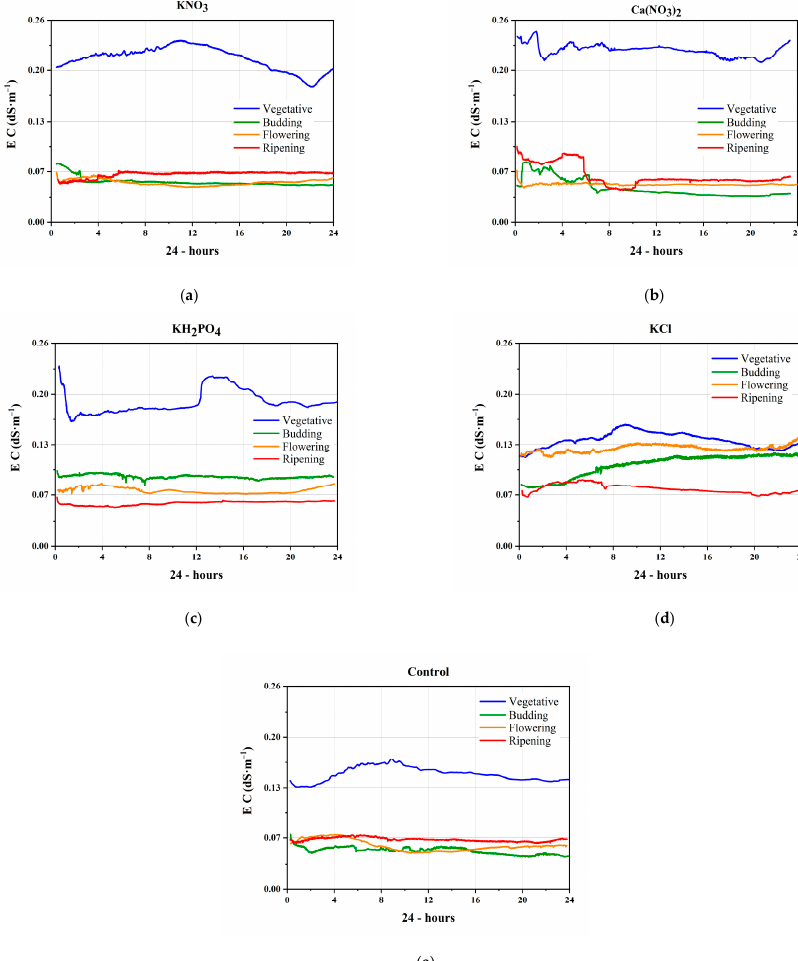
Figure 3. The 24 h electrical conductivities measured in different physiological stages for potassium nitrate ( a ), calcium nitrate ( b ), potassium dihydrogen phosphate ( c ), potassium chloride ( d ) and control ( e ). The 24 h ECs were recorded from the first day, at 9.30 a.m. till the next day at 9.30 a.m. The ECs were determined by using the indirect Ohm’s law method, based on the electrical signals recorded with a Keysight B2981A femto/picoammeter (fA).